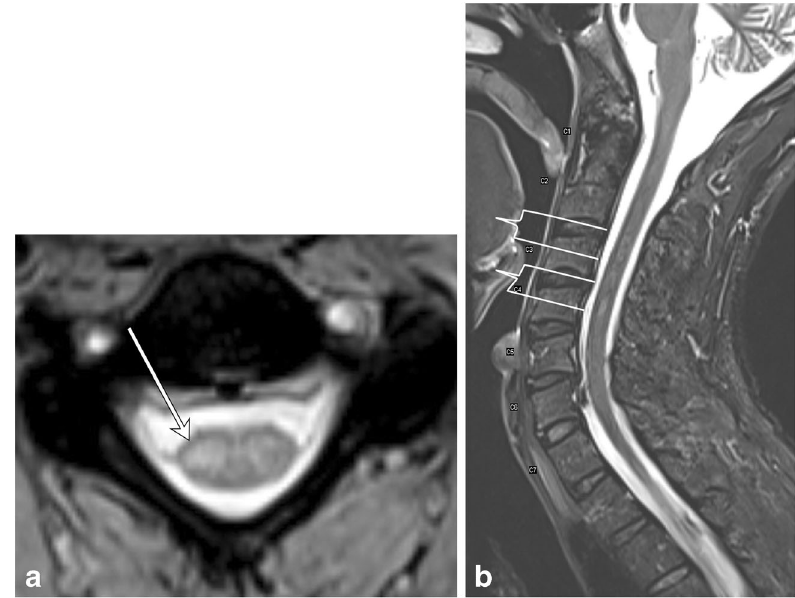
Fig. 4 Multiple sclerosis. A 50- year-old male with a history of multiple sclerosis. a Axial MERGE image demonstrates partial cord involvement — focal hyperintensity within the right lateral cord with a characteristic triangular shape (arrow). There is no cord enlargement. b Sagittal T2 fat-saturated image demon- strates several scattered, short- segment foci of T2 hyperintensity (brackets)